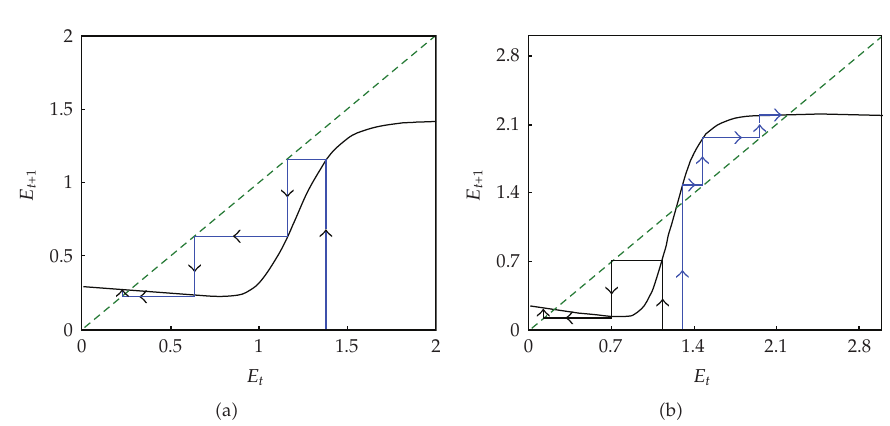
Figure 2: (cid:5) a (cid:6) Unique stable equilibrium. (cid:5) b (cid:6) Fold bifurcation and the birth of a poverty